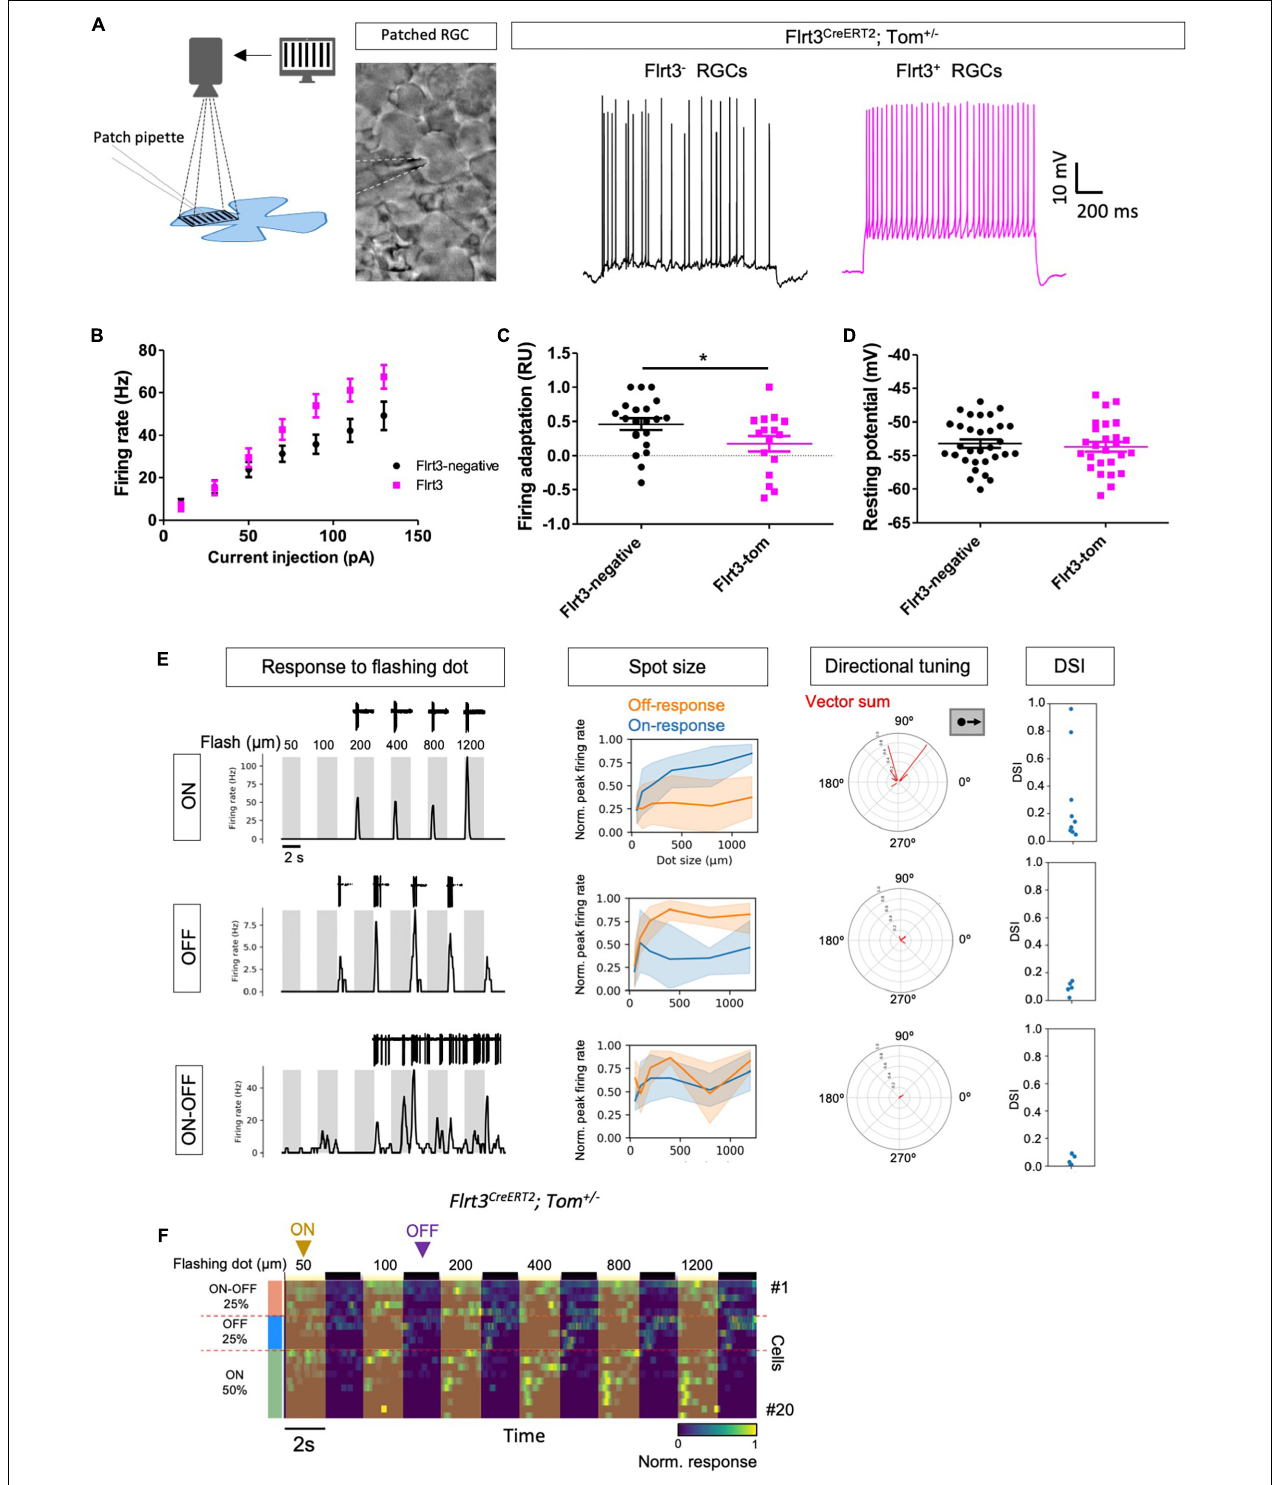
FIGURE 3 | Flrt3-Tom-RGCs are mainly ON neurons. (A) The left panel shows a schematic of the experiment in which an RGC is patch-clamped while different movie patterns are shown with a projector. The right panel shows representative whole-cell current-clamp recordings displaying firing after a step of current injection in Flrt3 + and Flrt3 − RGCs. (B) Plot showing the firing rate (Hz) after increasing current steps. (C) Firing adaptation from the recordings in (A) . A value for firing adaptation closer to 1 represents cells with a higher adapting firing, while a value closer to 0 is more regular (see section “Materials and Methods”). N = 16–21